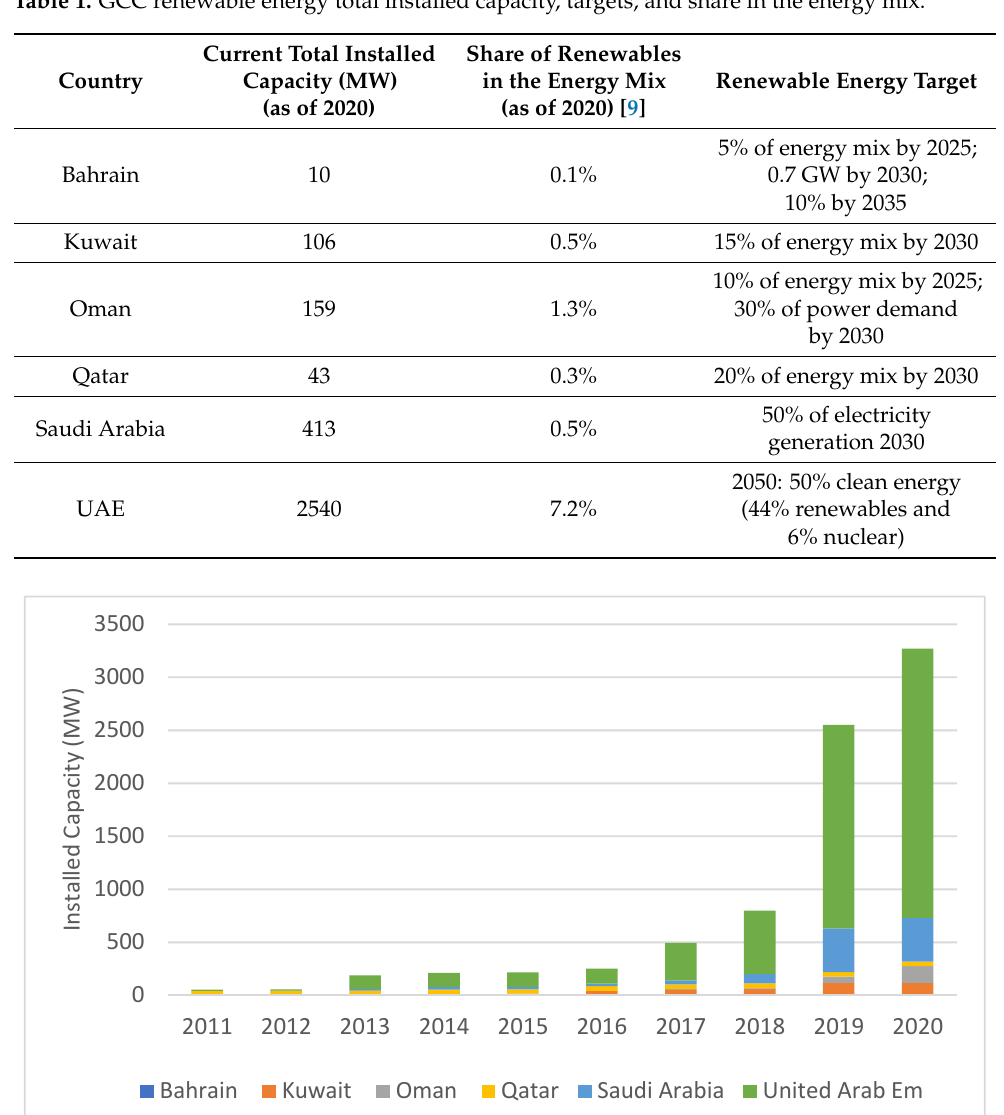
Figure 1. Renewable energy installed capacity in the GCC countries, 2011–2021 [9].